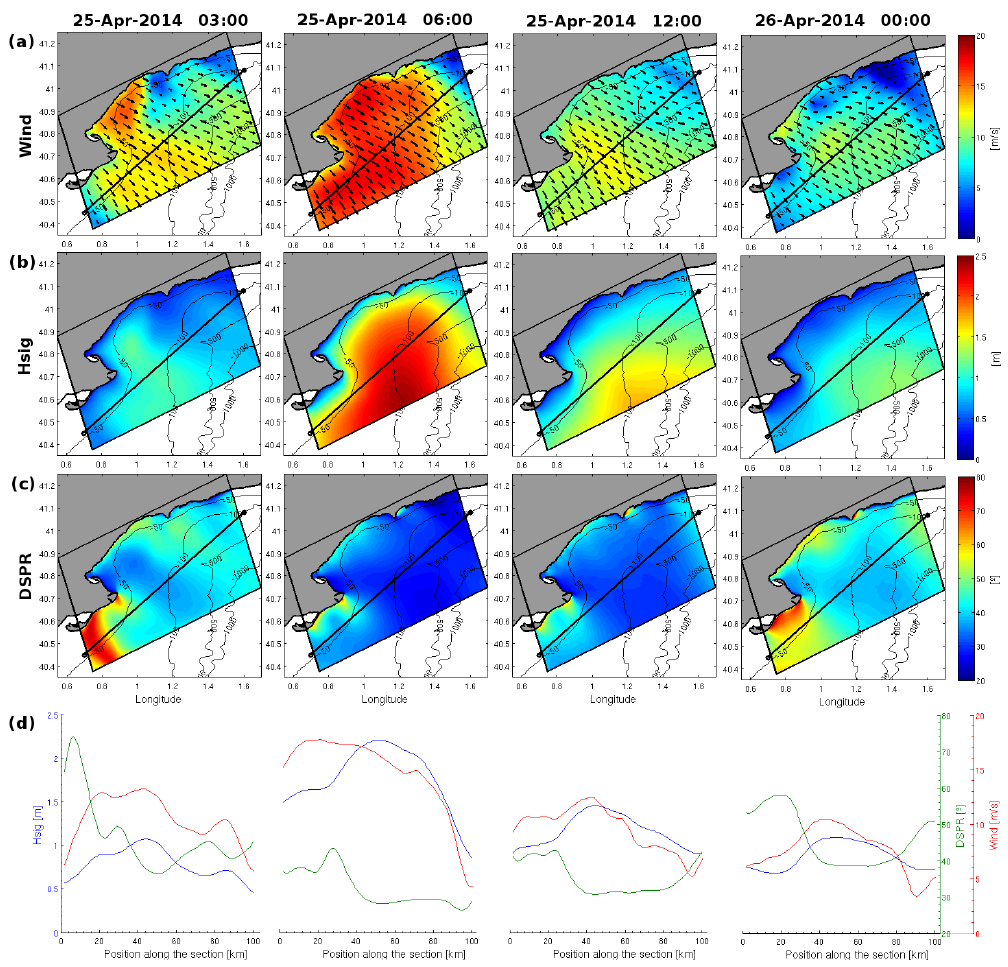
Figure 8. Model results for the wind-jet event E3. The figure shows the evolution of ( a ) the wind intensity, ( b ) the significant wave height, ( c ) the DSPR (directional spreading) and ( d ) the profile of the previous variables along the black line plotted in Panels ( a – c